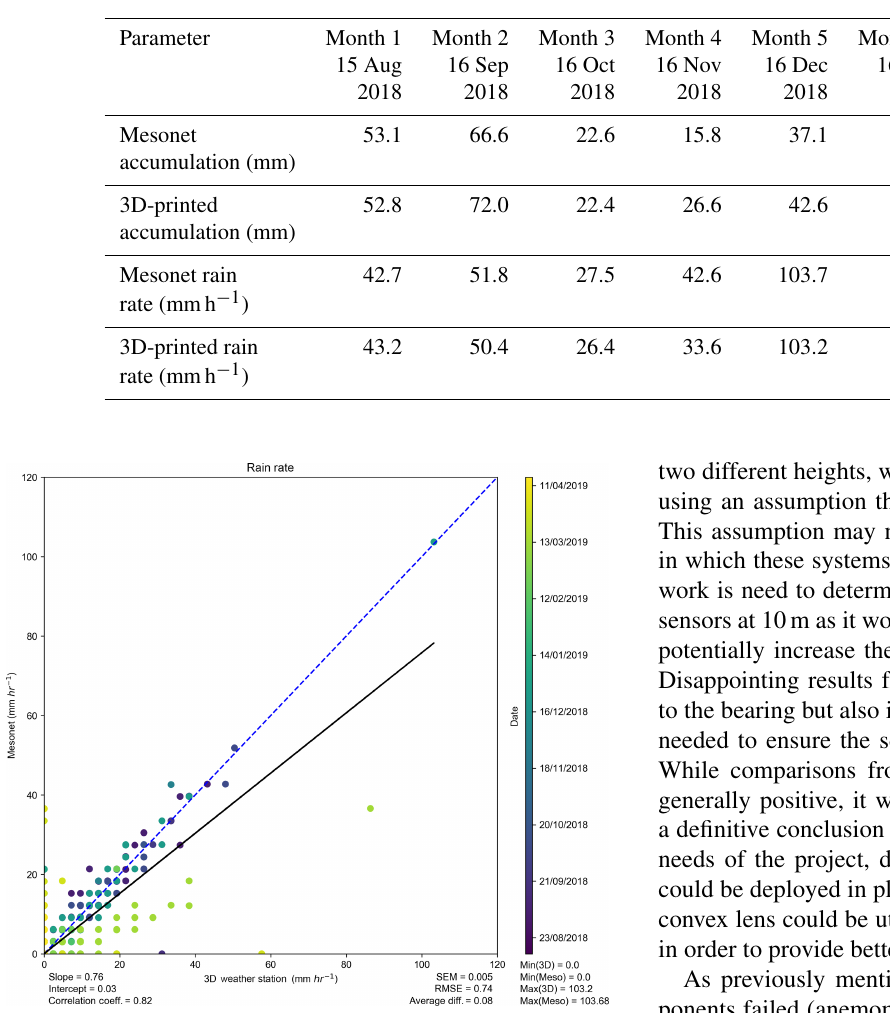
Table 6. Maximum precipitation rate and daily accumulation recorded each month.